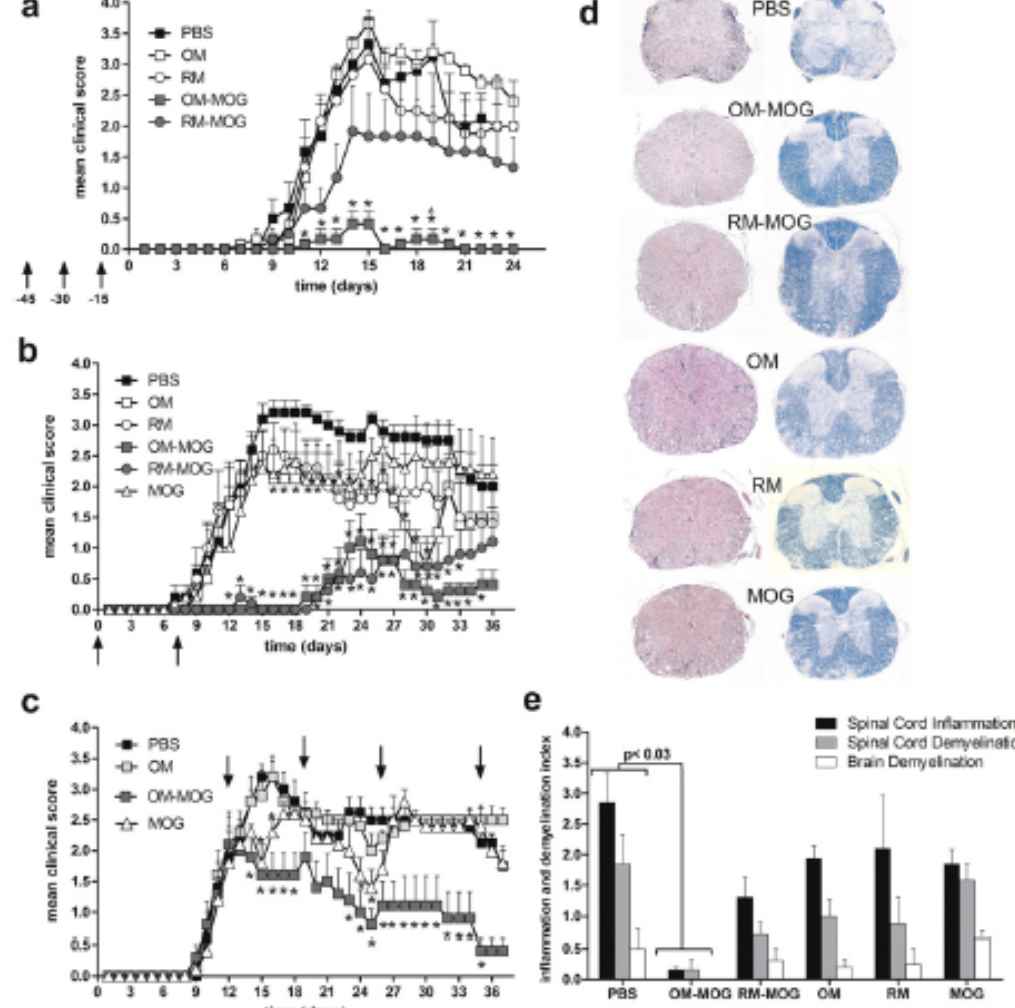
Figure 12. ( a ) Mean clinical scores of MOG-EAE in groups of mice vaccinated i.d. with OM-MOG, RM-MOG, OM, RM, or PBS at indicated time points (arrows) before immunization for EAE induction. ( b ) Mean clinical scores of MOG-EAE in groups of mice vaccinated i.d. at indicated time points (arrows) relative to immunization. ( c ) Mean clinical scores of MOG-EAE in groups of mice injected i.d. at indicated time points (arrows) after immunization. The results shown are from one representative of two ( b , c ) or three ( a ) independent experiments. ( d , e ) Vaccination with OM-MOG protects C57BL/6 mice from spinal cord inflammation and demyelination during MOG-EAE. ( d ) Inflammatory cell infiltration (left column) and demyelination (right column) were visualized on day 24 following immunization. ( e ) Quantification of spinal cord inflammation (black bars) and demyelination (grey bars) as well as brain demyelination (white bars) in all experimental groups. Representative data from five animals per group are shown. Statistical significance after comparisons between groups of mice (using the Kruskal-Wallis test) or histopathology indices (using Student’s t test) is shown (*, p < 0.05). Triangles ( a ) indicate time points where pair-wise comparison between OM-MOG and RM-MOG groups also show significant differences (with permission of [188]).